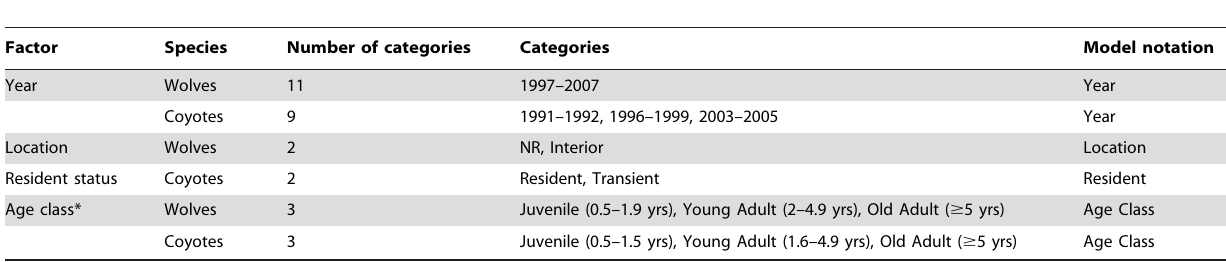
Table 1. Risk factors evaluated in the analysis of canid pathogen exposure in Yellowstone National Park, 1991–2007.